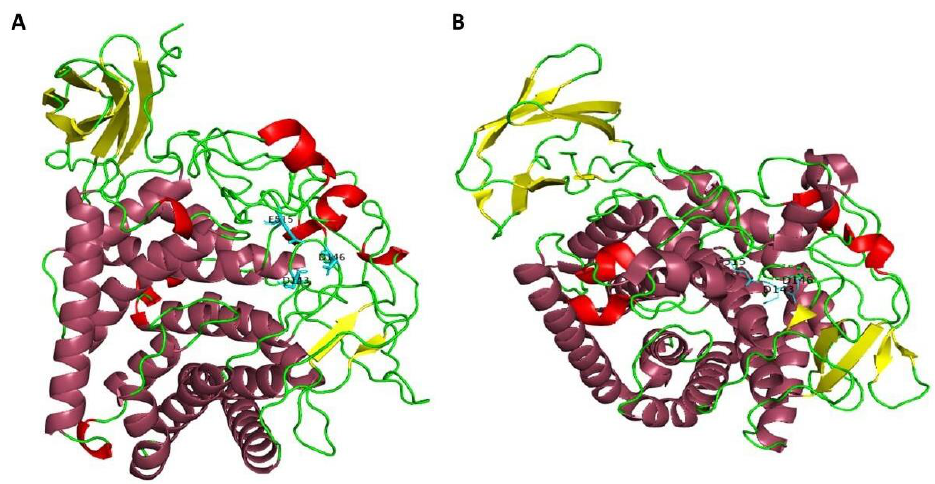
Figure 4. Structural comparison between the predicted 3D structure of AmCel9 ( A ) and the crystal structure of Cel9A of A. acidocaldarius ( B ) [45]. For both, the N-terminus Ig-like domain (yellow) is made up of seven β -sheets; the catalytic triad (light blue) is placed in the cleft of the catalytic (α/α)₆ barrel domain (purple).